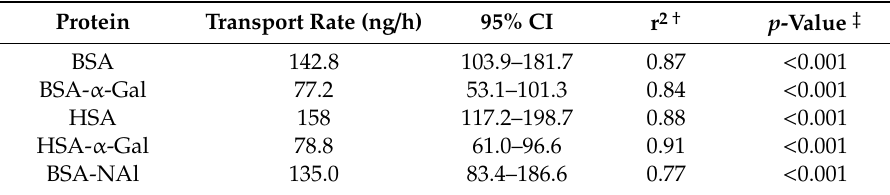
Table 1. Transport rates of the di ff erent proteins over the Caco-2